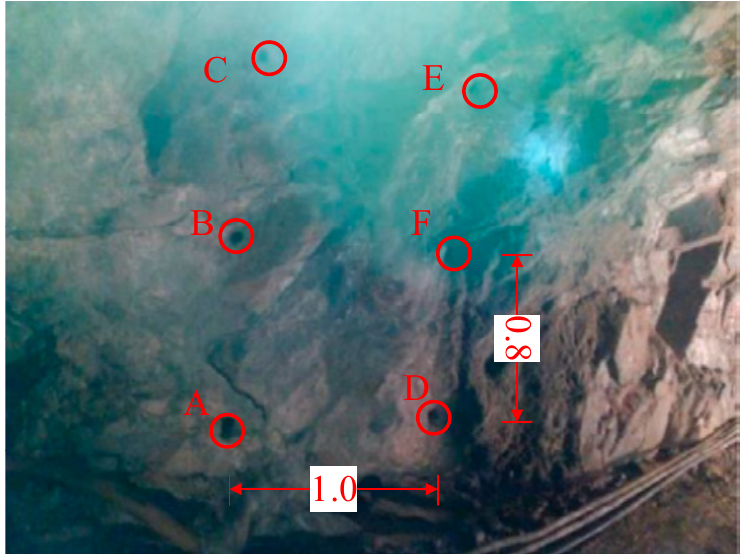
Figure 2. Field drilling diagram.